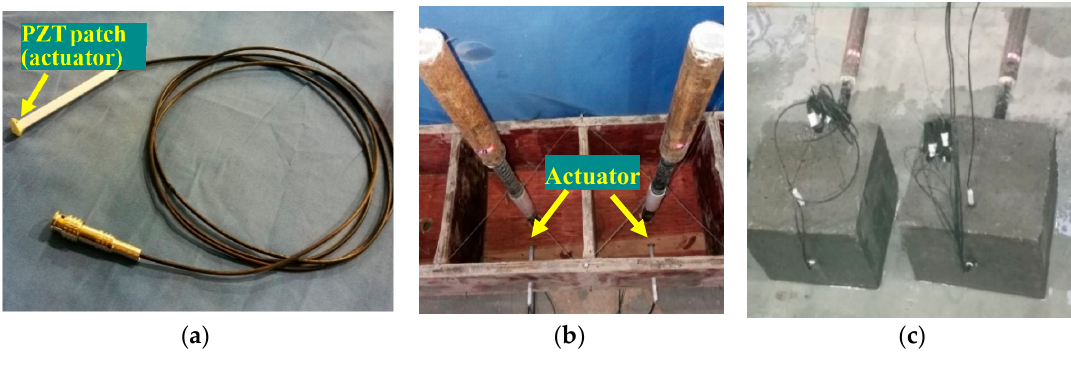
Figure 3. Fabrication of the test specimens. ( a ) A PZT patch actuator; ( b ) concrete mold; ( c ) concrete specimens. Sensors 2018 , 18 , x FOR PEER REVIEW